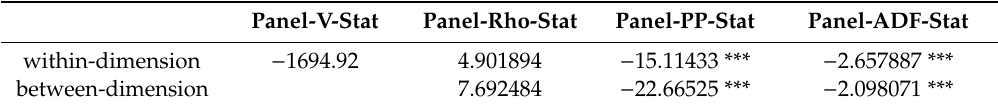
Table 7. Panel cointegration test results.